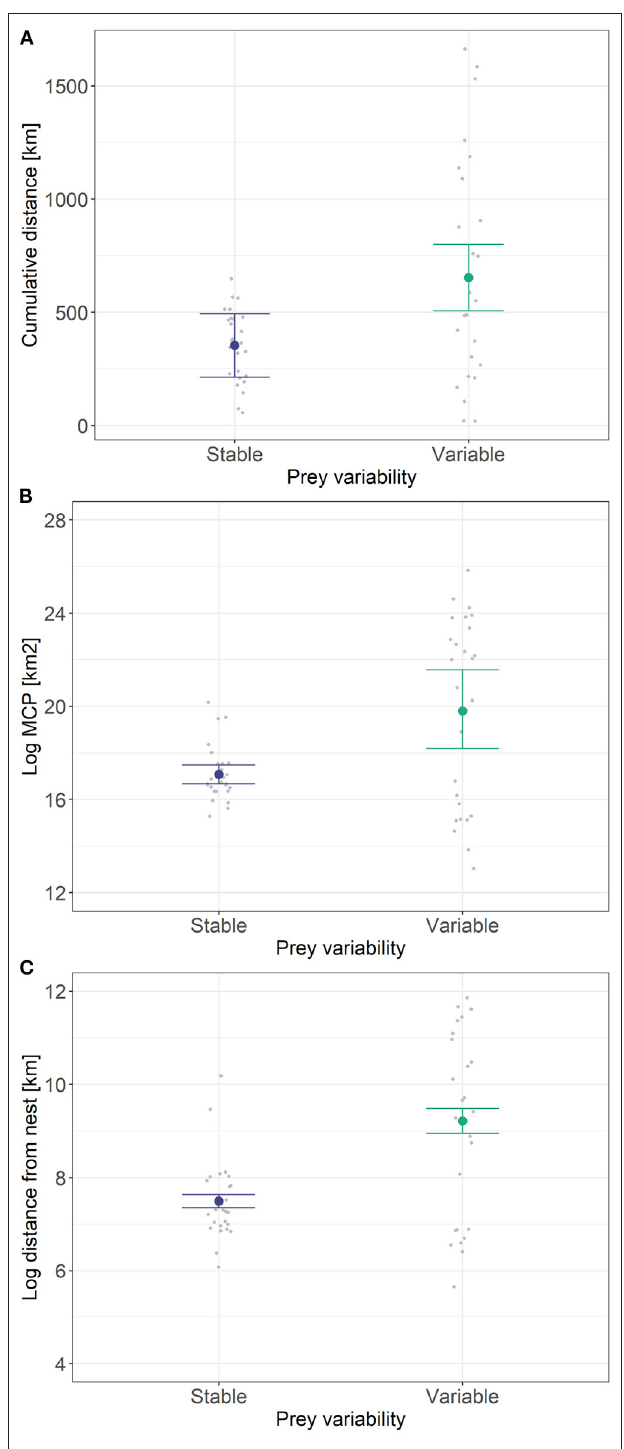
FIGURE 5 | (A) Cumulative distance, (B) MCP, and (C) distance from nest as a function of prey variability (stable vs. variable).